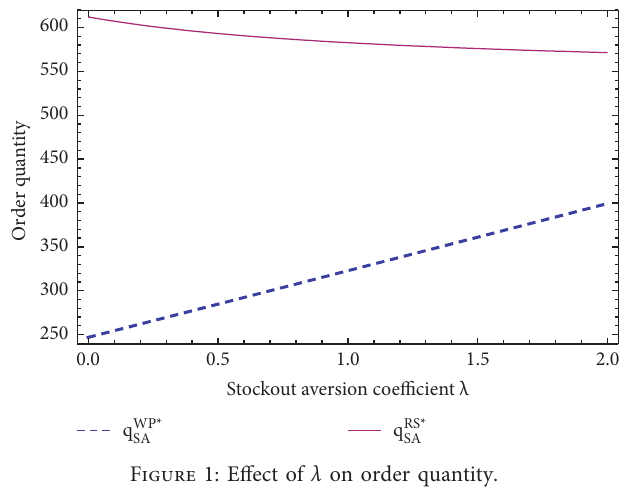
Figure 1: Effect of λ on order quantity.